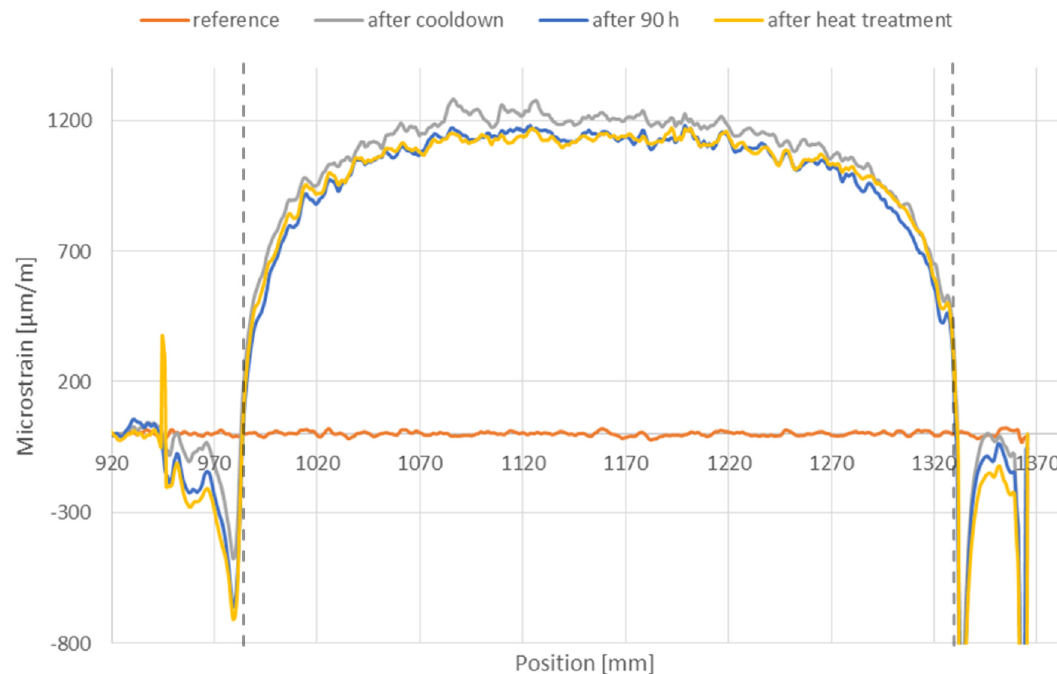
Fig. 9. Deformation after 90h rest and heat